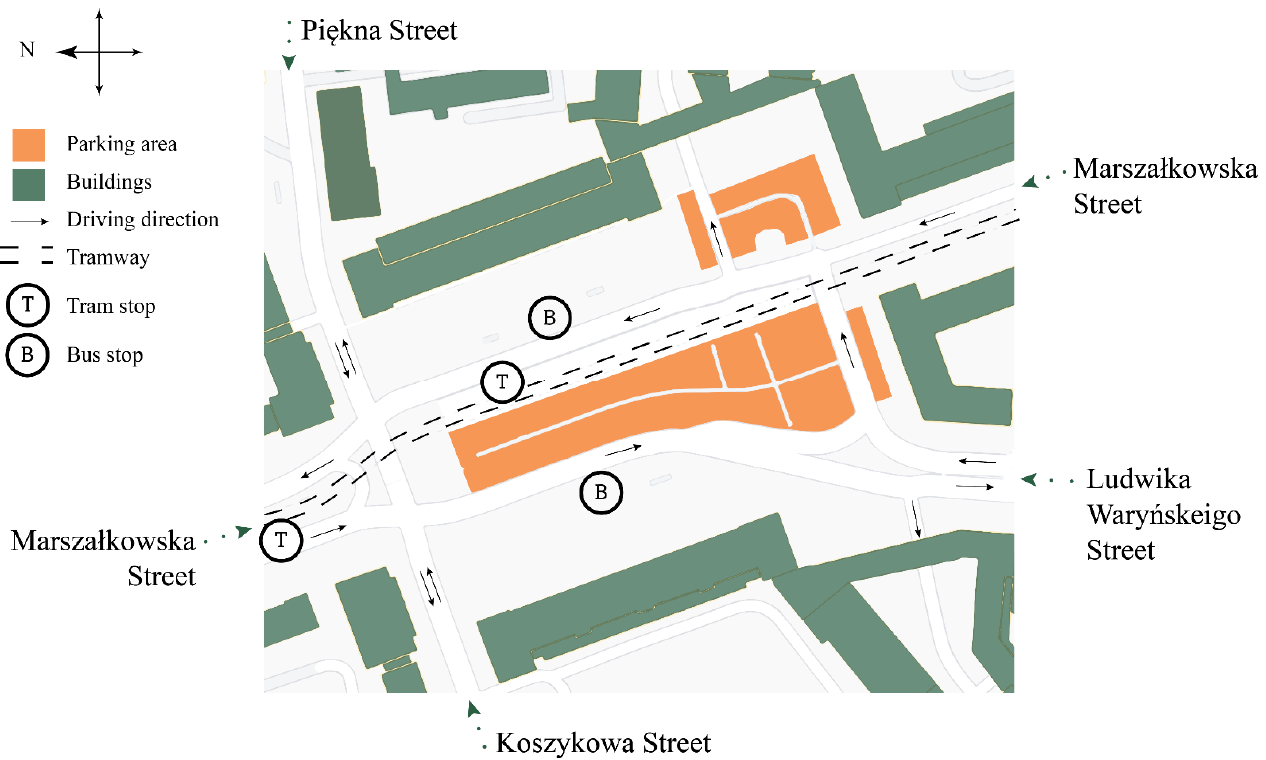
Figure 4. Current layout of Constitution Square in Warsaw, with an overview of the key communication elements.